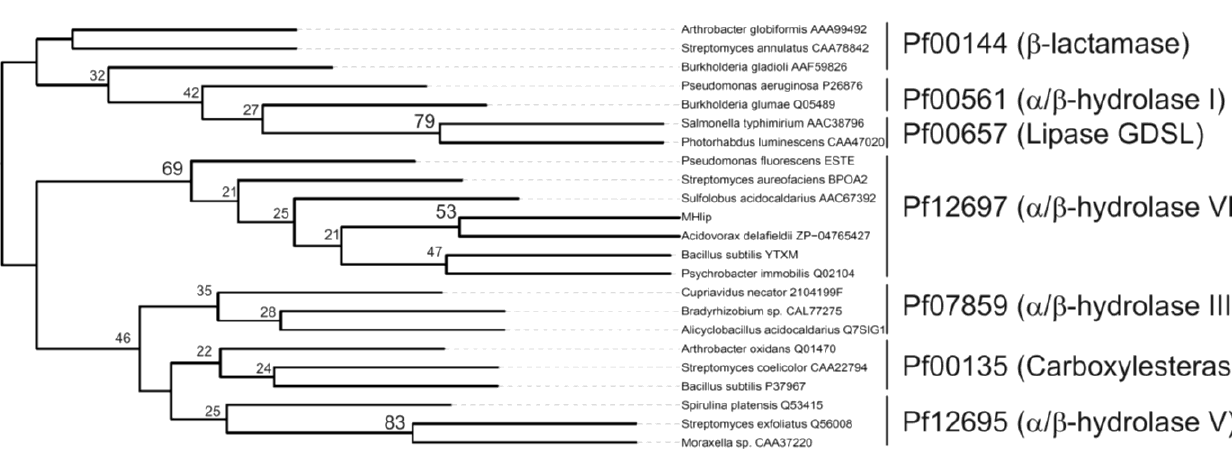
Figure 1. Unrooted neighbour-joining tree built with enzymes belonging to different families of esterases. The Jones-Tailor-Thornton method was used to compute distances [28]. Higher bootstrap values are displayed at the nodes and expressed as percentages of 1000 replicates. The Pfam numbers (names) are displayed on the right side of the